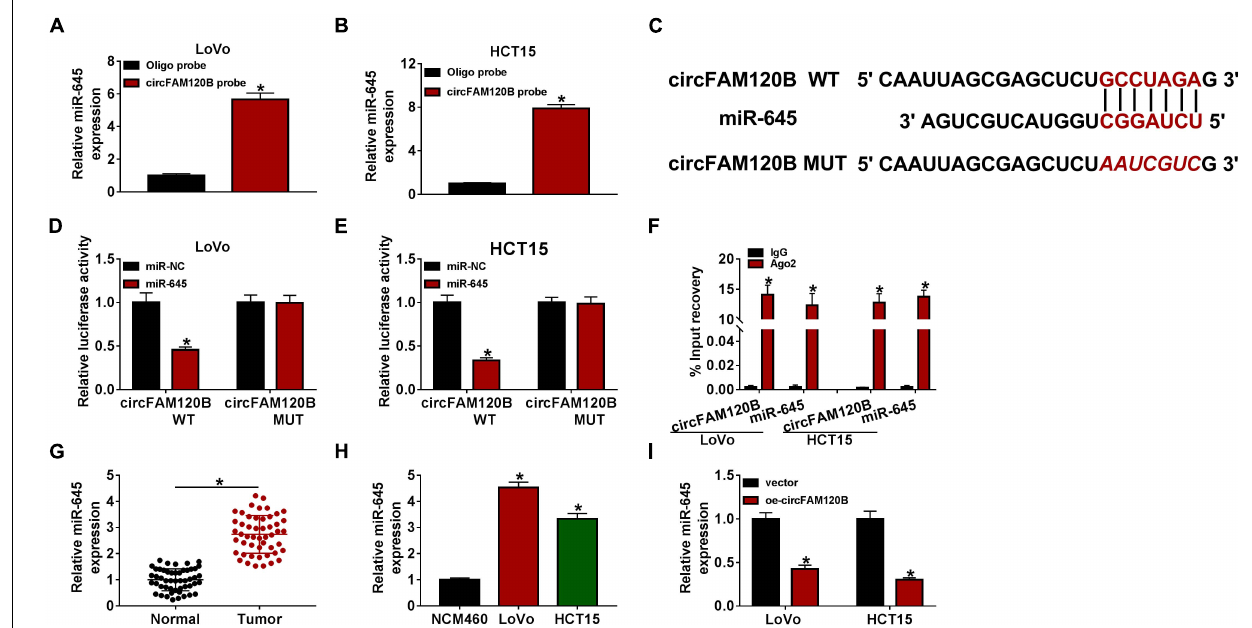
FIGURE 3 | MiR-645 was a target of circFAM120B. (A,B) Biotinylated-circFAM120B probe could significantly enrich the level of miR-645. (C) Wild-type circFAM120B sequence containing miR-645 binding sites was mutated to generate mutant-type circFAM120B sequence for dual-luciferase reporter assay. (D,E) Dual-luciferase reporter assay was performed to further validate the relationship between miR-645 and circFAM120B. (F) RIP assay was performed to validate the relationship between miR-645 and circFAM120B. (G) The expression of miR-645 in tumor tissues ( n = 50) and normal tissues ( n = 50) was detected by qRT-PCR. (H) The expression of miR-645 in LoVo, HCT15, and NCM460 cells was detected by qRT-PCR. (I) The expression of miR-645 in LoVo and HCT15 cells with circFAM120B overexpression was detected by qRT-PCR. * P < 0.05.